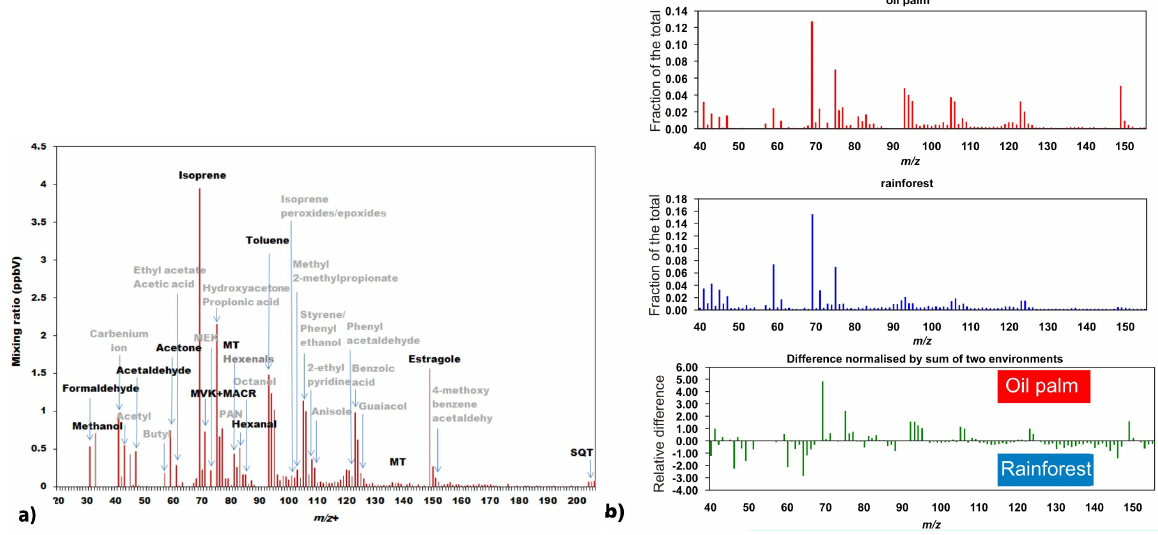
Fig. 1. (a) VOC composition at the oil palm plantation; averaged data of the campaign. Compounds whose identification was not entirely unambiguous are presented in grey; (b) relative comparison to rainforest (see Sect.